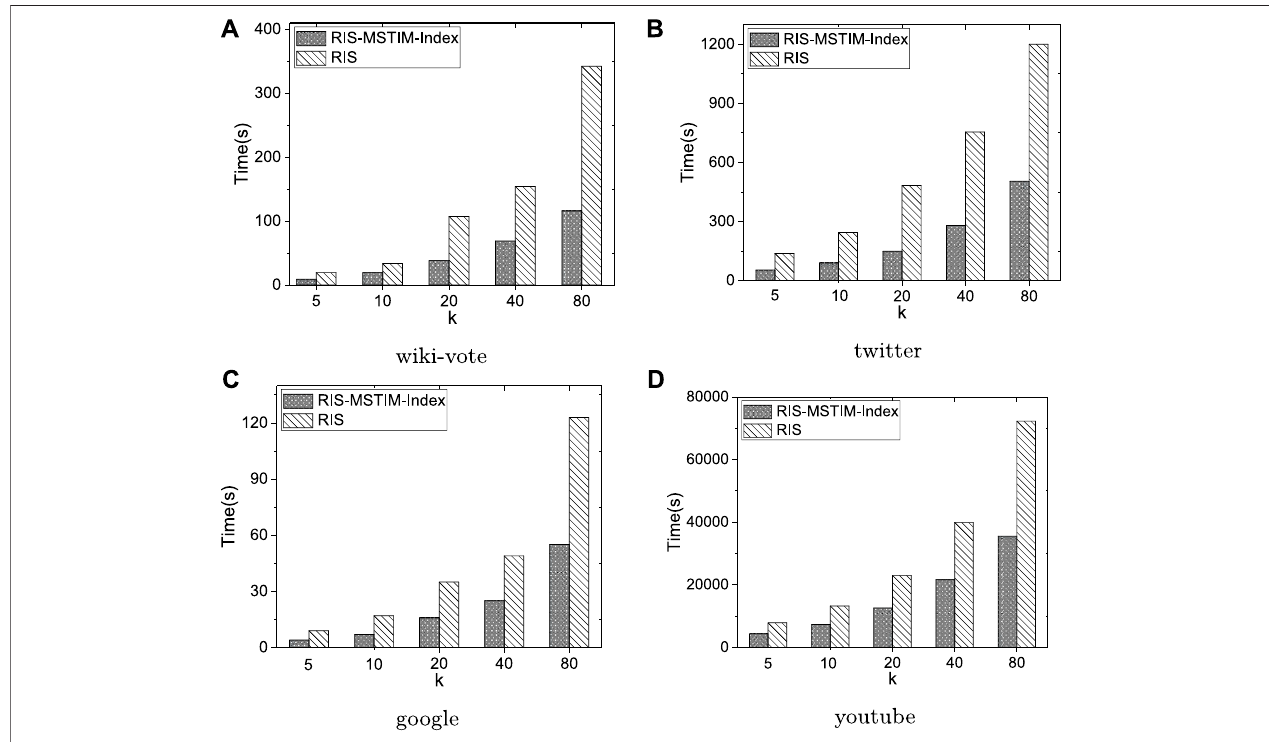
FIGURE 7 | The average time cost of targeted in fl uence maximization algorithm for evaluating the randomly generated query groups over four datasets.